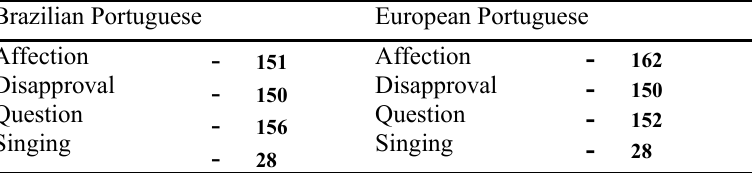
Table I: Organization of the instances